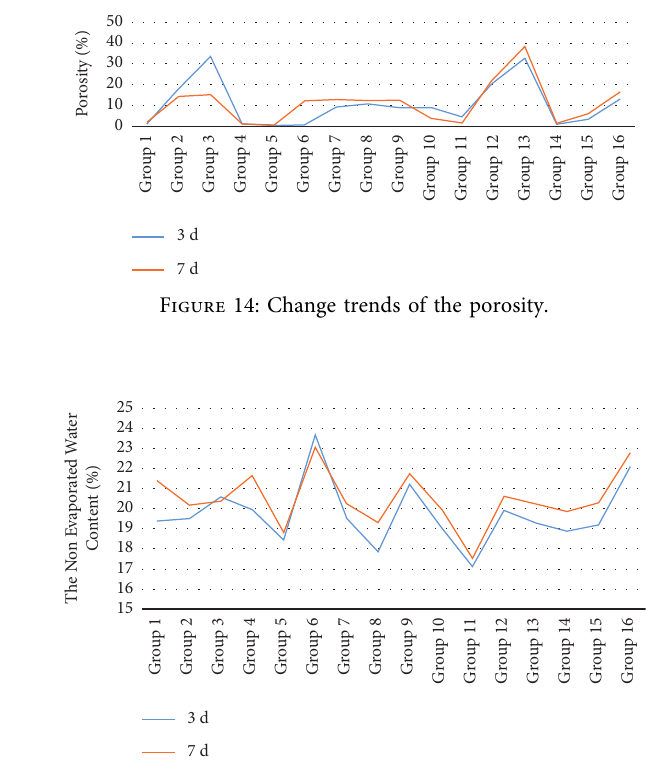
Figure 15: Change trends of the nonevaporated water